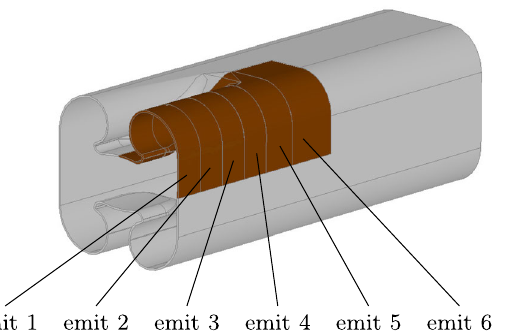
FIG. 12. Secondary electron yield (SEY) of Nb after 300 °C baking and after a surface treatment with argon [15].